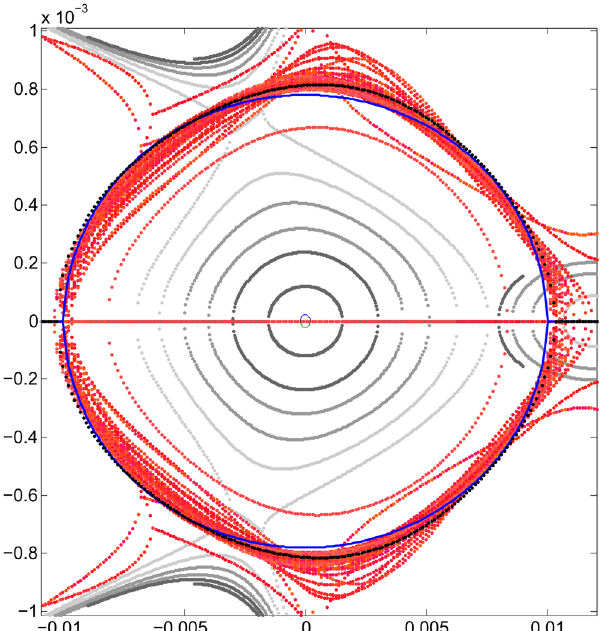
Figure 9. Enlargement of the phase space ( x , p x ) of Fig. 8 that depicts the set of inner branches (red) of the nonlinear problem in greater detail. These are intermediate solutions in the optimization process, from which the sextupoles, that minimize the objective function f obj , arise. With the new sextupoles { S 2 } , obtained by optimizing at 10 mm, we see that the estimated dynamic aperture (black) has grown beyond 10 mm. The black solution is the best approximation to the ellipse (blue) that represents the linear solution, according to the Courant-Snyder invariant. The gray tone curves show the structure of the underlying phase space (Fig. 7) before doing the new optimization using x 0 = 10